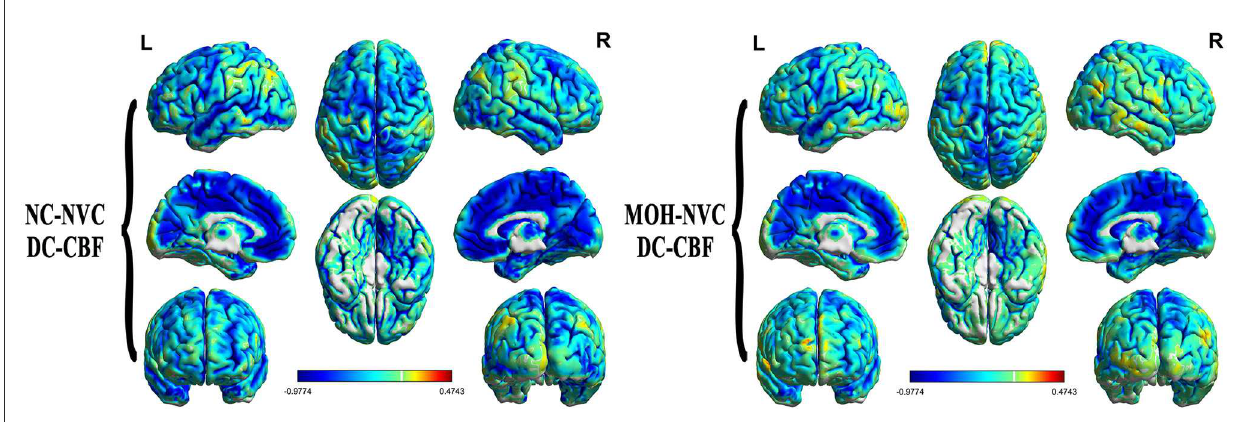
FIGURE9 DC–CBF connectivity of NCs and patients with MOH, mainly indicating a negative correlation over the entire gray matter level.